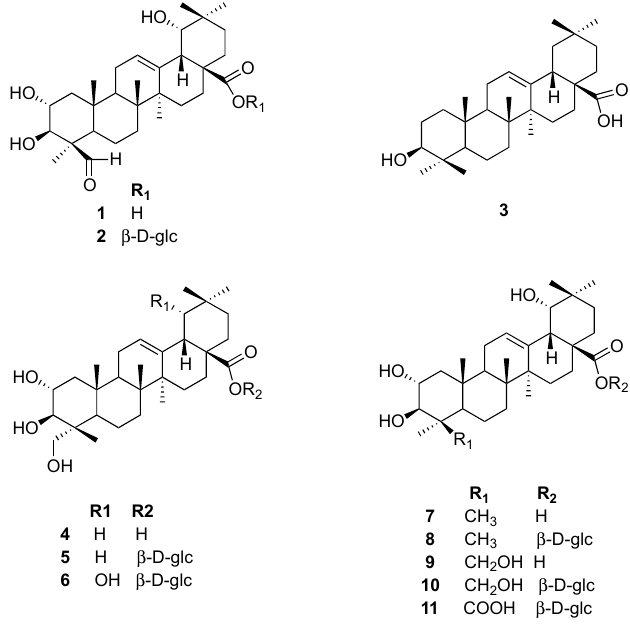
Figure 1. Oleanolic triterpenes isolated from acorns.